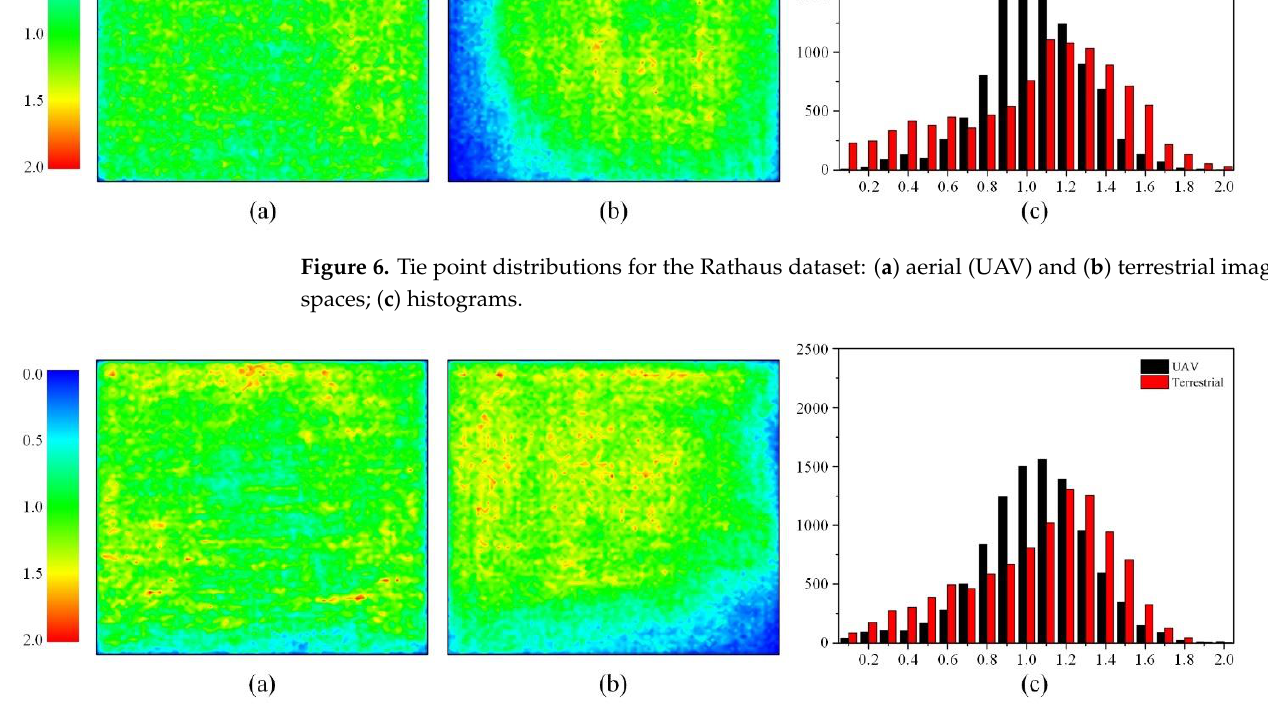
Figure 7. Tie point distributions for the Stadthaus dataset: ( a ) aerial (UAV) and ( b ) terrestrial image spaces; ( c ) histograms.